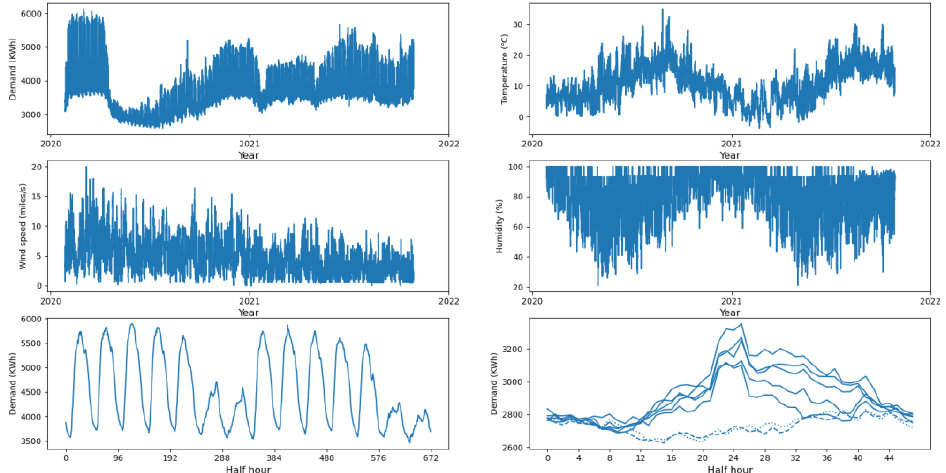
Figure 5. Load demand and features data. Load demand data for the period 1 January 2020 – 31 September 2021 ( top left ); Temperature data for the period 1 January 2020 – 31 September 2021 ( top right ); Wind speed data for the period 1 January 2020 – 31 September 2021 ( middle left ); Humidity data for the period 1 January 2020 – 31 September 2021 ( middle right ); daily and weekly periodicities in the period 2 March 2020 – 15 March 2020 ( bottom left ); daily load demand curves in a week for the period 18 May 2020 – 24 May 2020. Solid lines: weekdays; dashed lines: Saturdays; dotted lines: Sundays ( bottom right ).